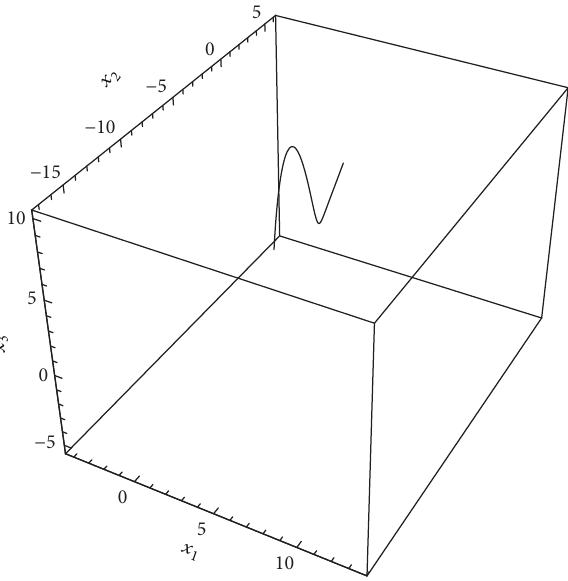
Figure 1: The phase curves of the system (1), projection on 𝑥 𝑥 ) plane ( 𝑘 = 1 ). (𝑂𝑥 1 2 3